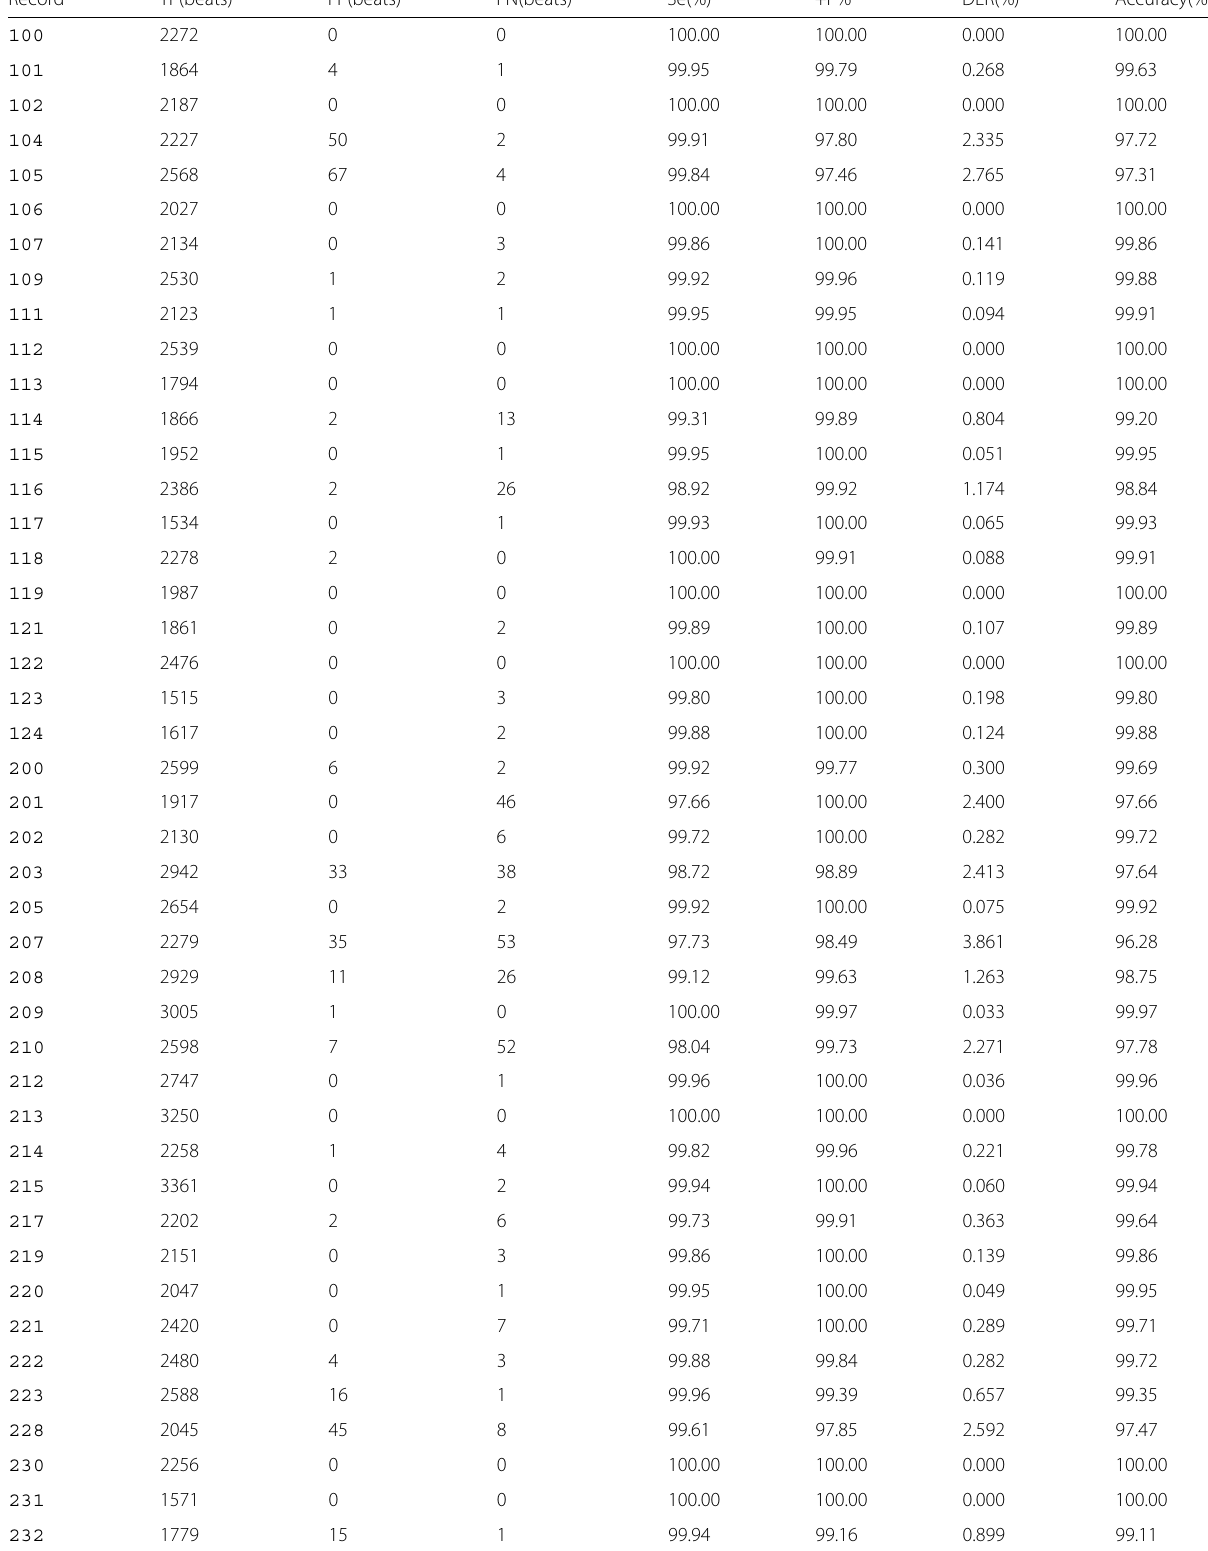
Table 2 Performance evaluation of the proposed R-wave detection method with the MIT-BIH arrhythmia